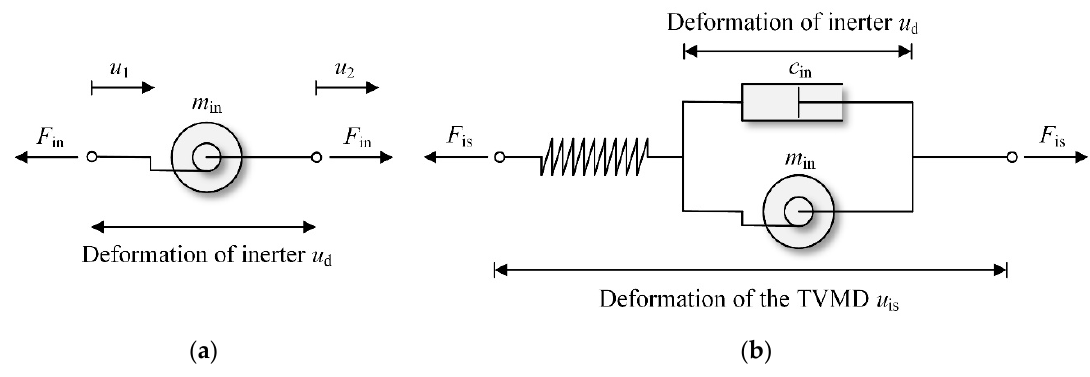
Figure 1. The mechanical schematic of the inerter and the tuned viscous mass damper (TVMD): ( a ) the inerter; ( b ) the TVMD.